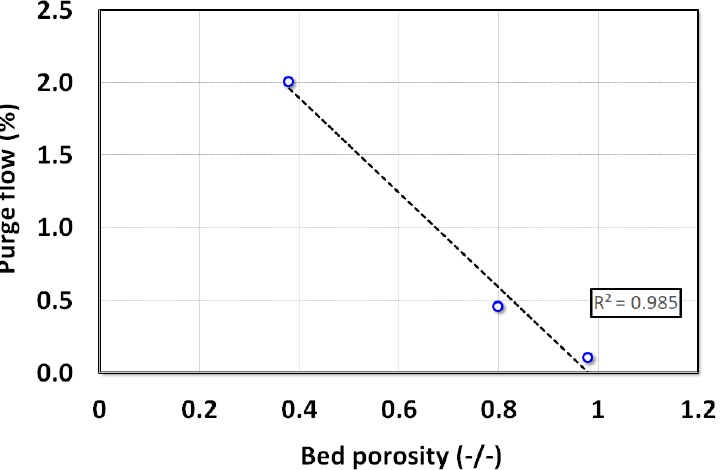
Figure 13. Effect of the bed voidage on the ratio of the purge flow to the total volume during gas deaeration .